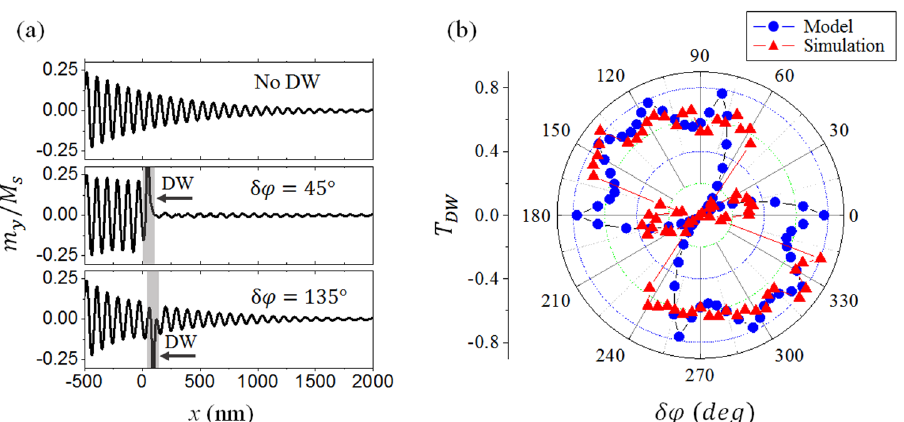
Figure 5. Transmission of SW with 20 GHz frequency as in the case of Fig. 3(d). ( a ) Spatial variation of the normalized m y component without and with DW for δϕ = 45° and 140°. Shaded areas indicate the domain wall region. ( b ) Polar plot of the transmission ratio versus δϕ . Blue circles are calculated results and the red triangles are from